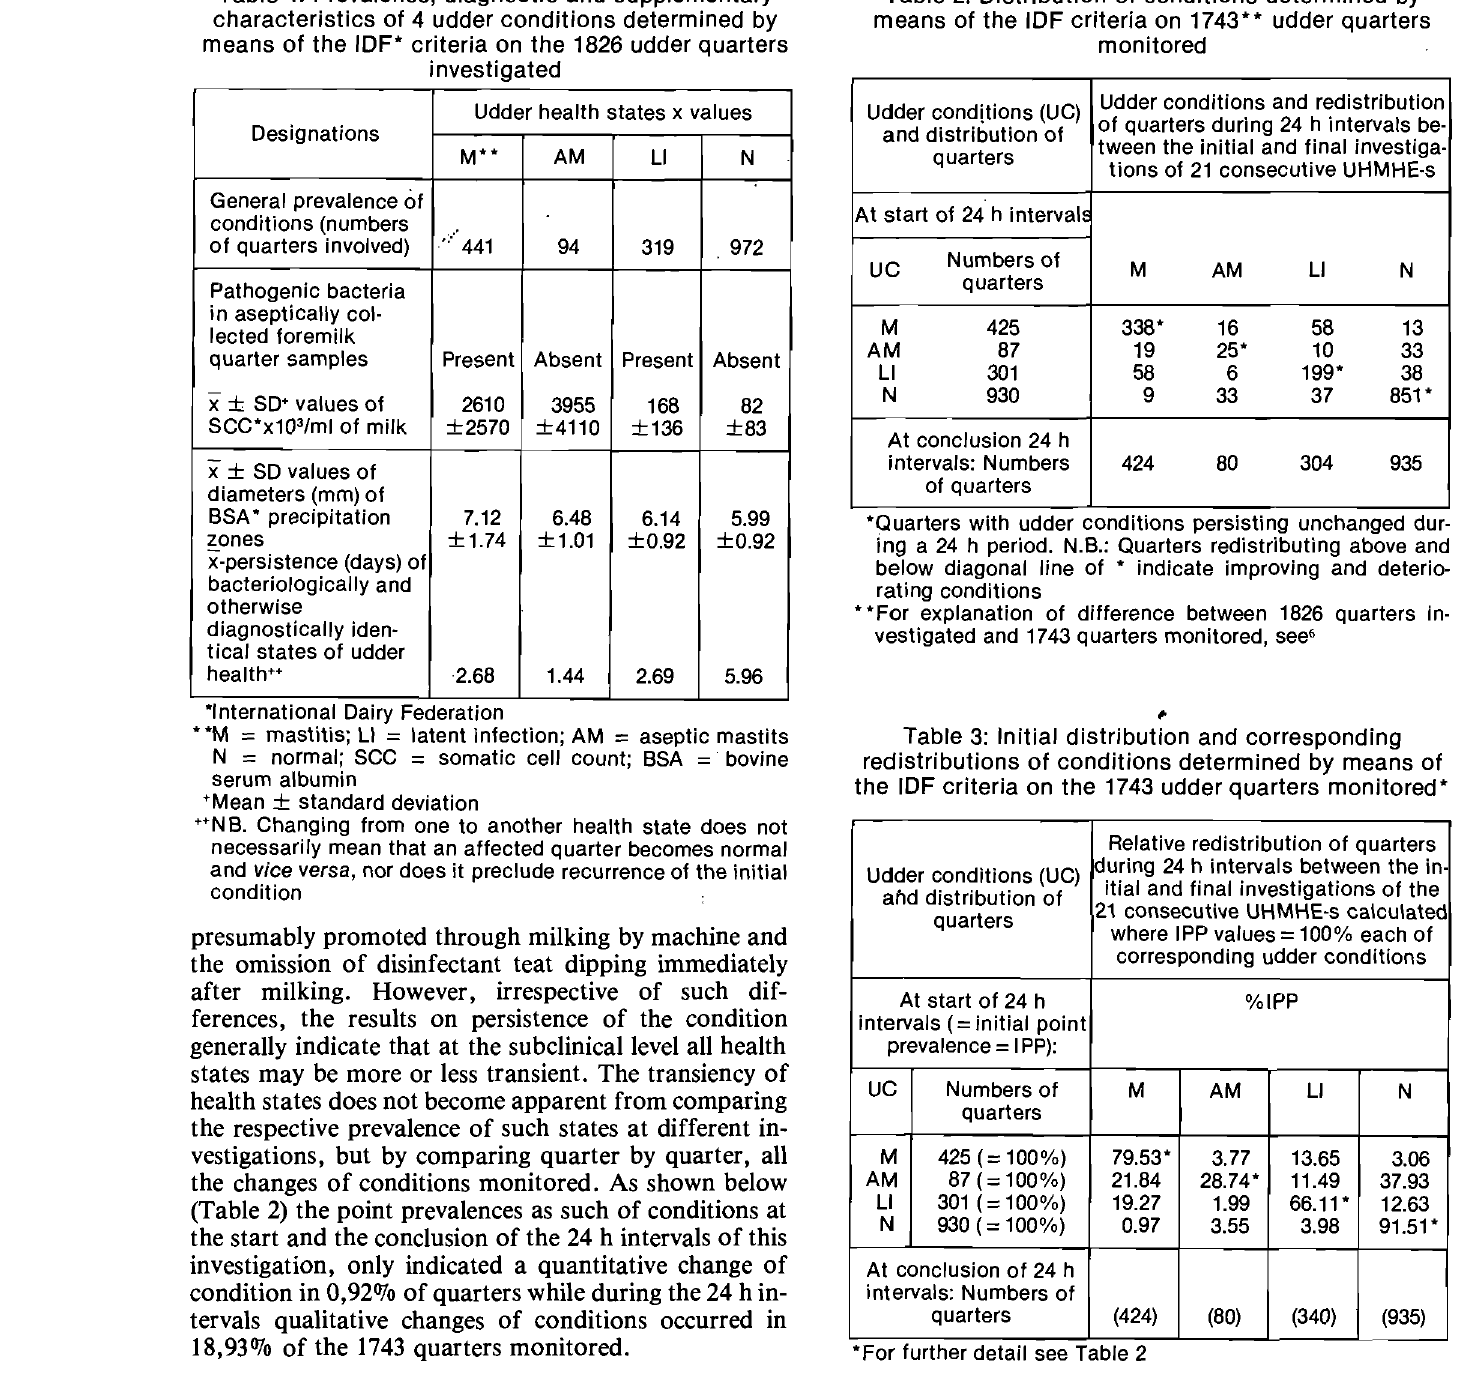
Table 2: Distribution of conditions determined by means of the IDF criteria on 1743** udder quarters monitored Udder conditions and redistribution Udder conditions (UC)